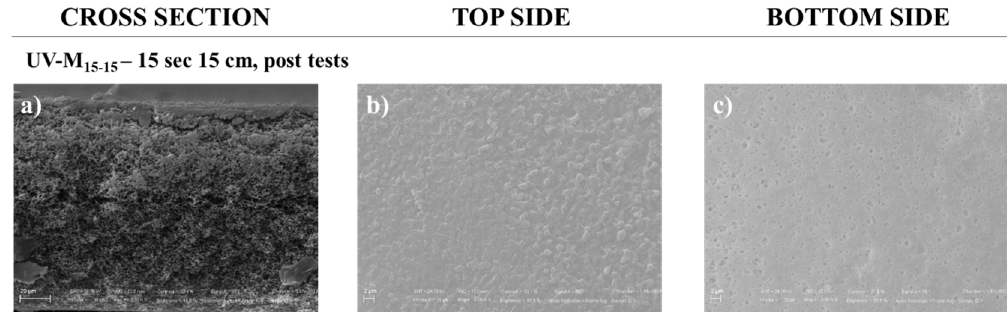
Figure 7. SEM pictures of the UV-M 15-15 PES membrane after tests of HA rejection and cleaning with magnification of 4.00 KX for ( a ) cross-section and ( b ) top side, and magnification of 10.00 KX for ( c ) bottom side.